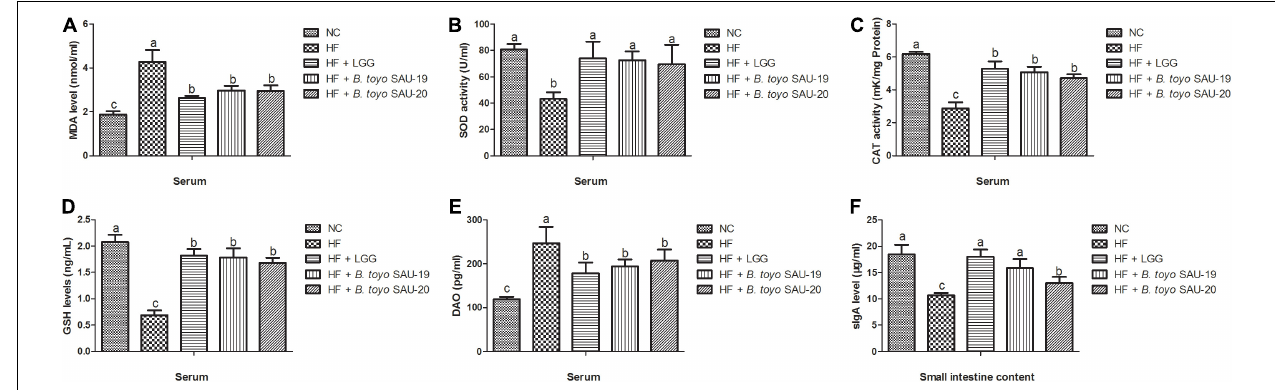
FIGURE 4 | Effect of Bacillus toyonensis SAU-19 and SAU-20 on antioxidant indexes, DAO and sIgA activity in mice fed high fat diet (A) levels of MDA enzyme in serum, (B) levels of SOD enzyme in serum, (C) levels of CAT enzyme in serum (D) levels of GSH enzyme in serum (E) DAO concentrations in the serum, (F) sIgA levels in small intestine contents. Bars represent means ± standard deviation (SD). The values are presented as the mean ± SD. Bars without the same letter differed significantly ( n = 6, P < 0.05). NC, mice were administered normal diet + normal saline; HF, mice were fed high fat diet + normal saline; HF + LGG, mice were administered high fat diet + 10 6 Lactobacillus rhamnosus GG; HF + B. toyo. SAU-19, mice were administered high fat diet + 10 6 Bacillus toyonensis SAU-19 from A. adenophora ; HF + B. toyo. SAU-20, mice were administrated with high fat diet + 10 6 Bacillus toyonensis SAU-20 from A. adenophora .